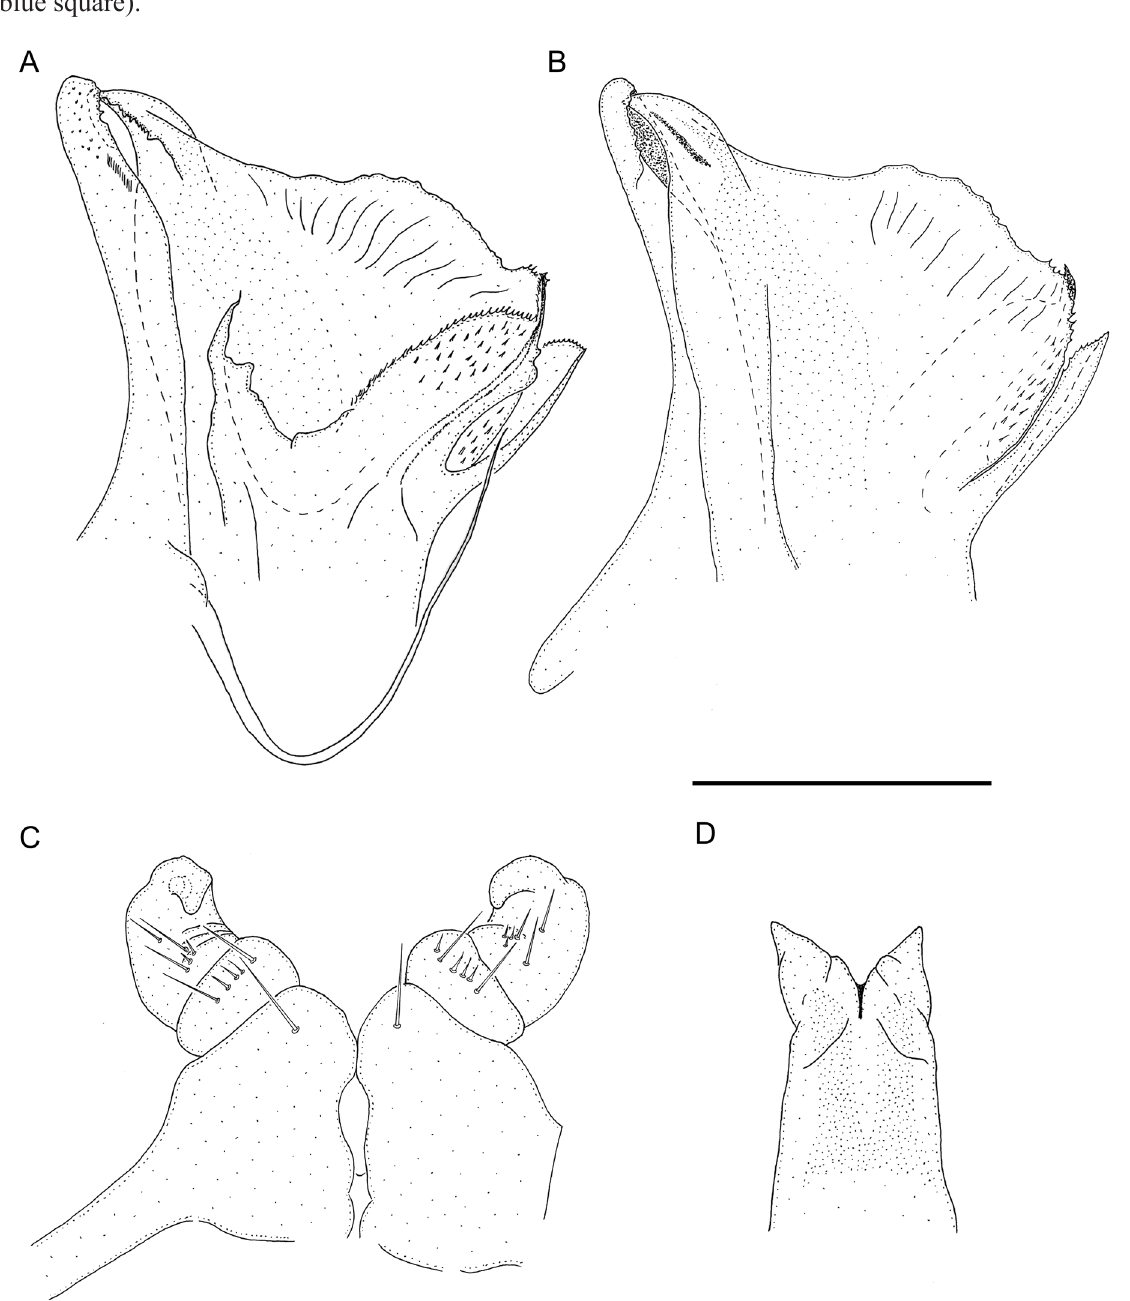
Fig. 38. Leucogeorgia caudata sp. nov., paratype ♂ from Novoafonskaya Cave (IZB). A . Left gonopods, mesal view. B . Right gonopods, lateral view. C . Leg-pair 1, anterior view. D . Penes, posterior view. Scale bar: 0.3